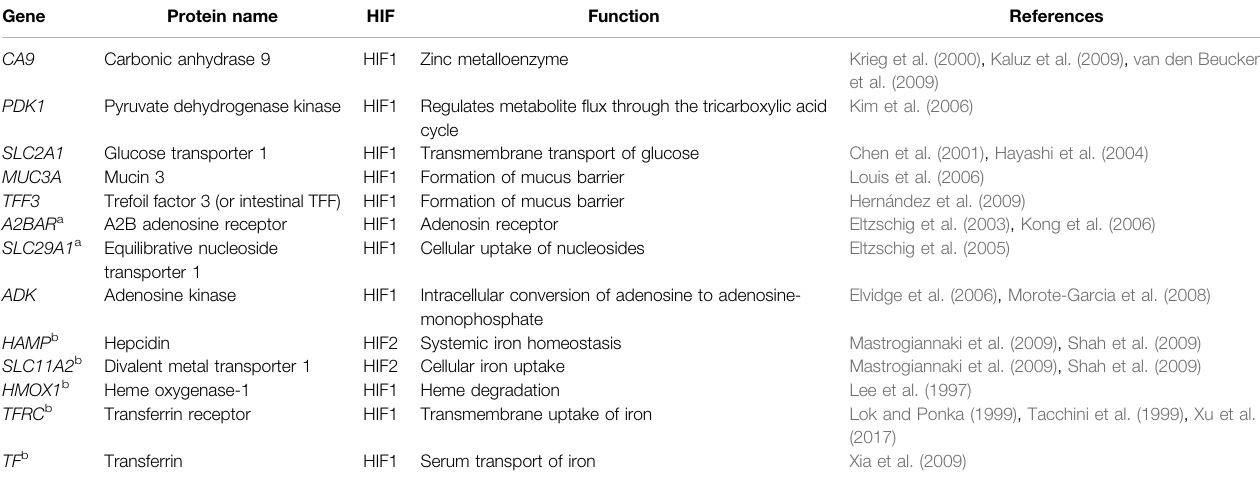
TABLE 3 | Description of analyzed HIF(1/2)-regulated